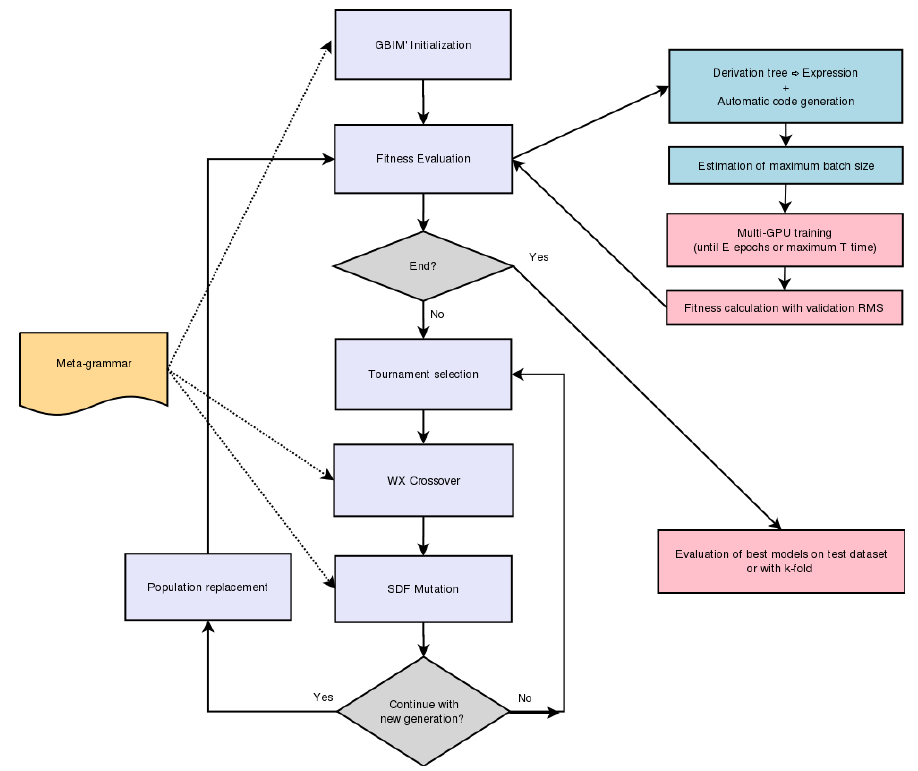
Figure 3. VGNet: network architecture design